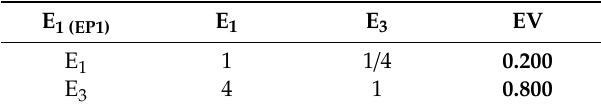
Table 6. Pairwise comparison and EV values of E 1 and E 3 by expert 1 targeting the interior interdependences of E 1 .